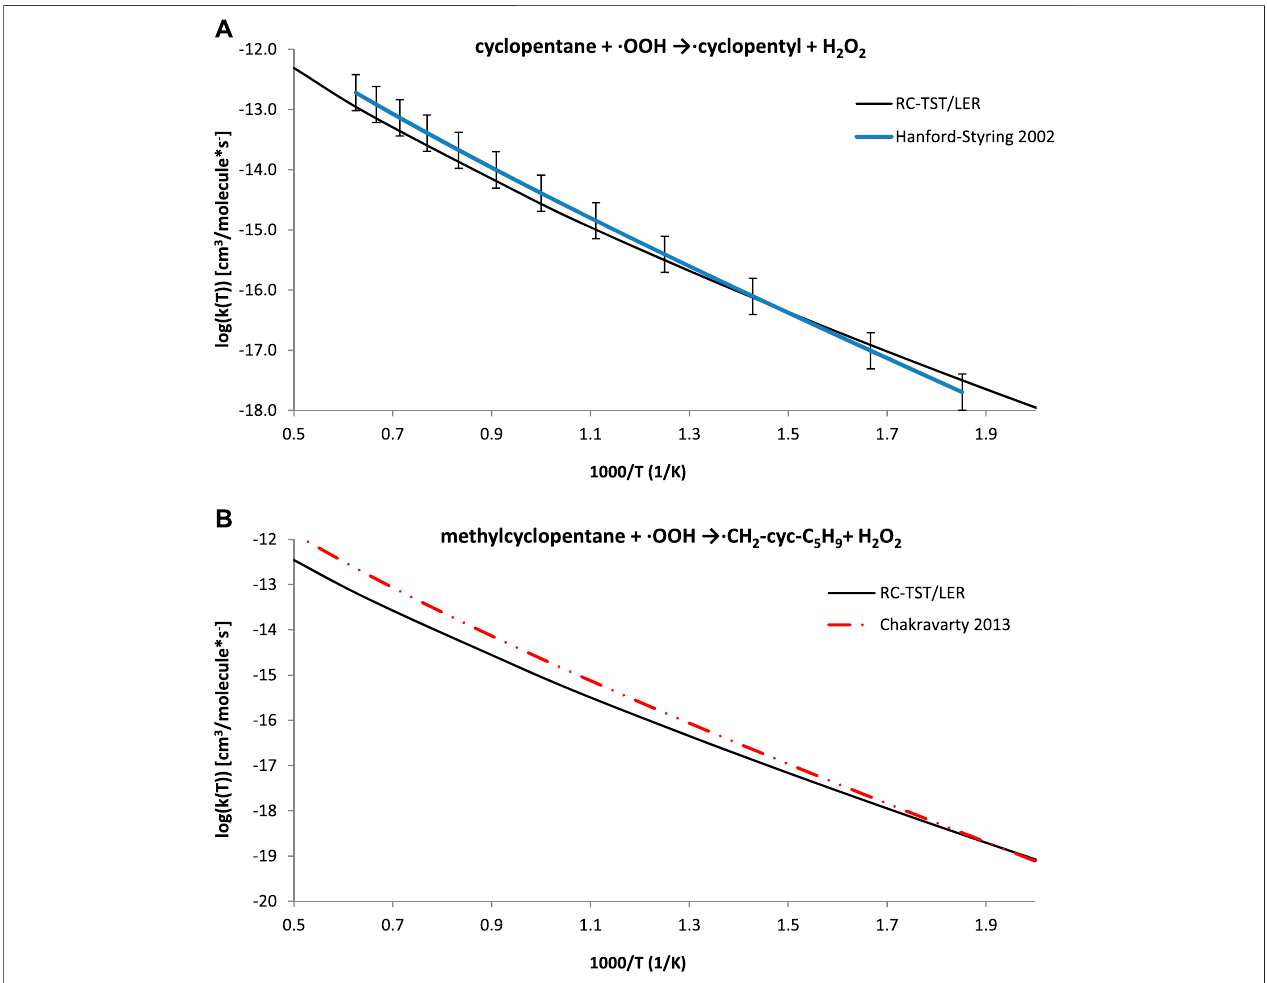
FIGURE 10 | Arrhenius plots of the computed and literature rate constants calculated with the RC-TST/LER approach for the: (A) cyclopentane + · OOH → cyclopentyl +